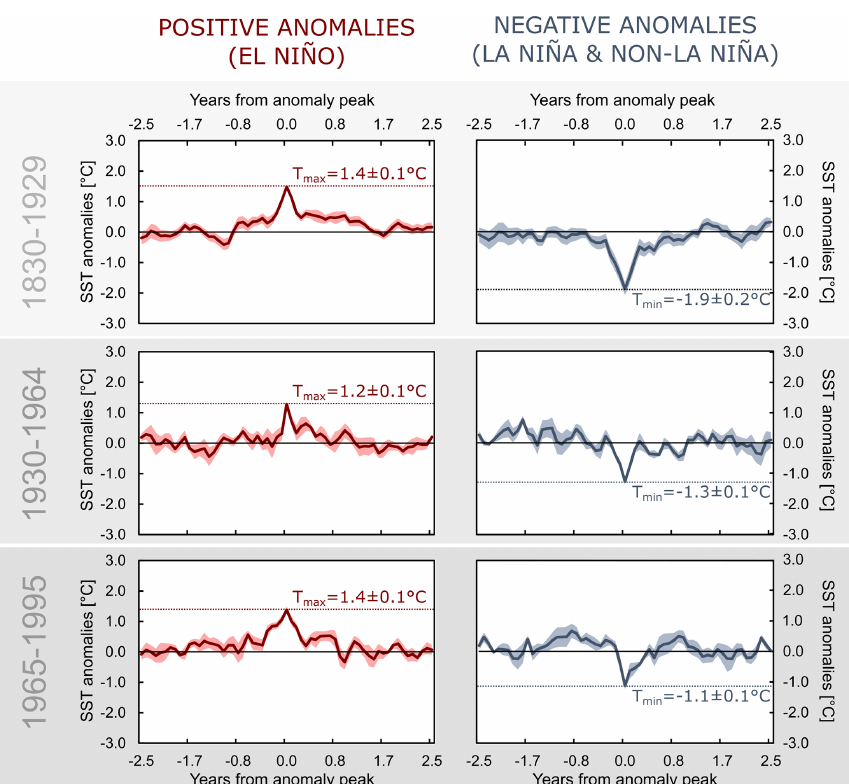
Figure 9. Positive (El Niño events; left) and negative SST anomaly (La Niña and non-La Niña events; right) composite records of the 19– 20th century coral SST records separated by the 1830–1929 (top row), 1930–1964 (middle row), and 1965–1995 (bottom row) time intervals. Shaded areas below and above the curves show the standard error for the mean values of the composite records. See Table 5 for an overview of the events that were selected for generating the